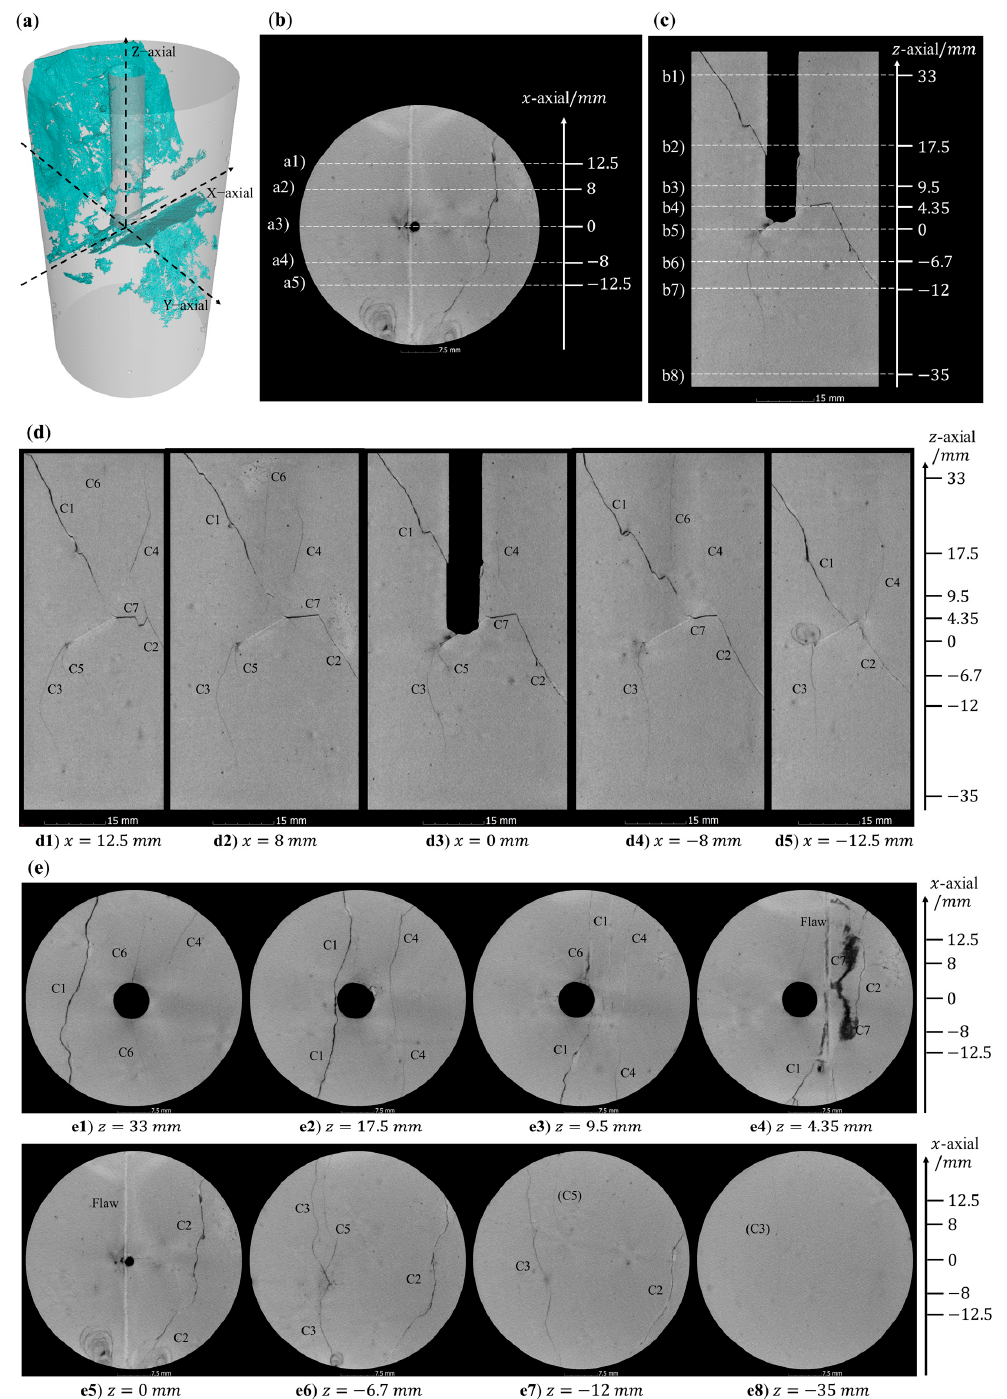
Figure 10. Part of cross-sections of 30-4-1 specimen after failure. ( a ) Schematic diagram of space coordinate system; ( b , c ) schematic diagram of section cutting position; ( d ) front vertical cross-sections with different depths; ( e ) horizontal cross-sections with different heights.